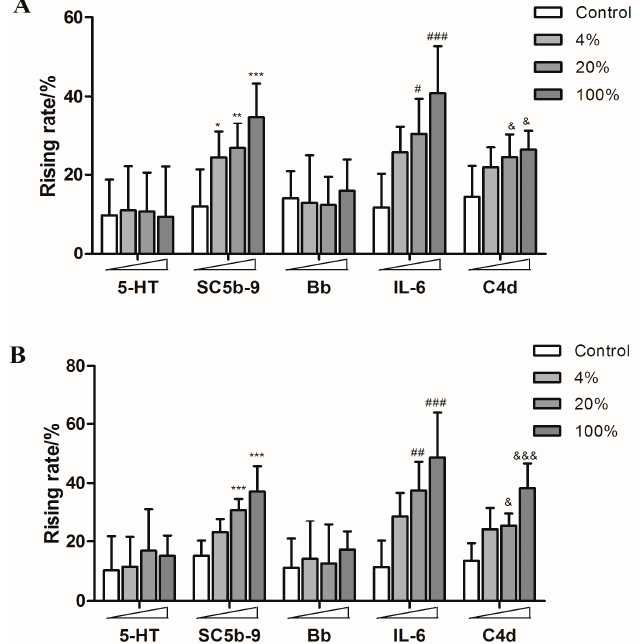
Figure 7. The rising rates of 5-HT, SC5b-9, Bb, IL-6, and C4d in animals ′ plasmas after treating with different doses of amiodarone hydrochloride injection and toad venom injection (( A ): amiodarone hydrochloride injection; ( B ): toad venom injection). * p < 0.05, ** p < 0.01, *** p < 0.001 vs. control; # p < 0.05, ## p < 0.01, ### p < 0.001 vs. control; & p < 0.05, &&& p < 0.001 vs. control ( n = 10).